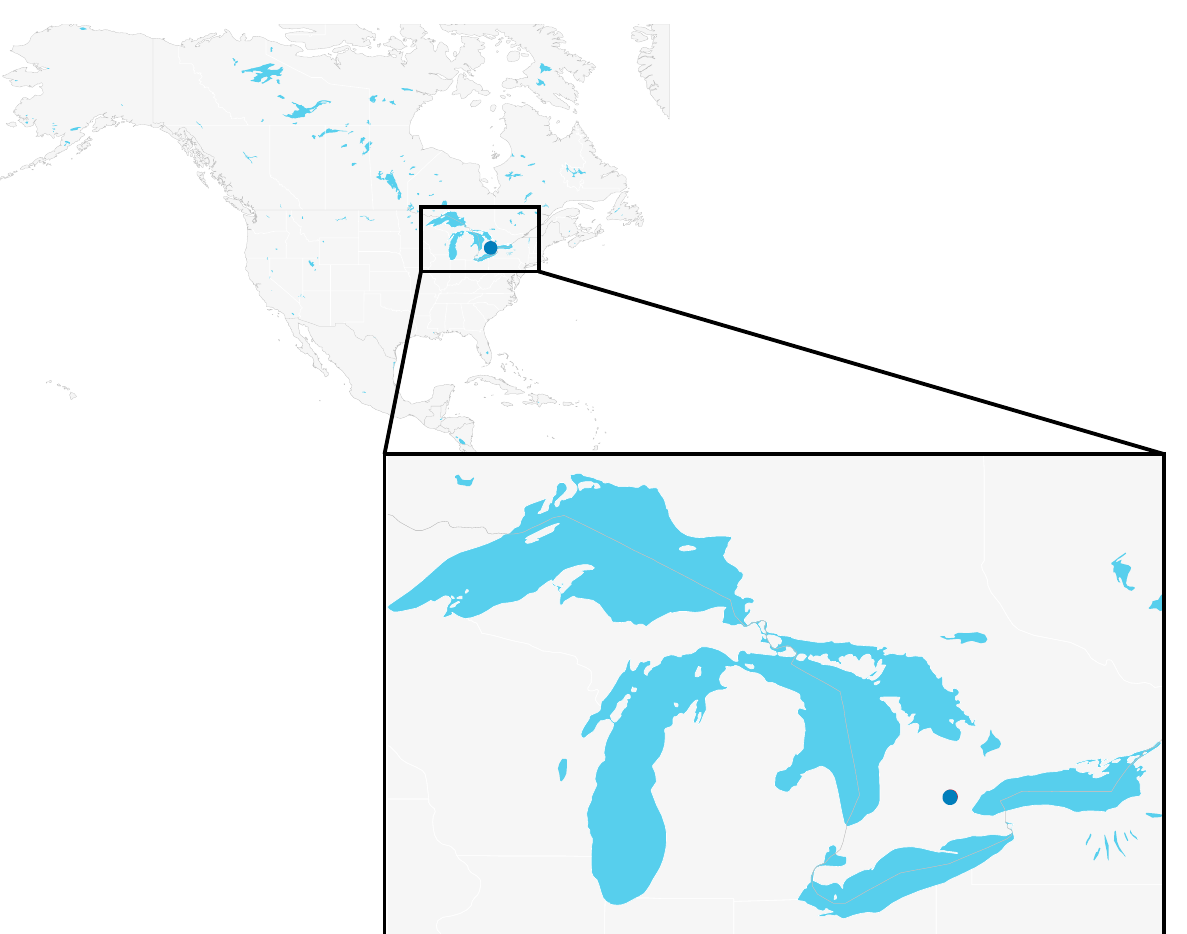
Figure 1. Map of North America showing collection sites (dots). A link to an interactive version of the map is also provided (Supplementary material S1).